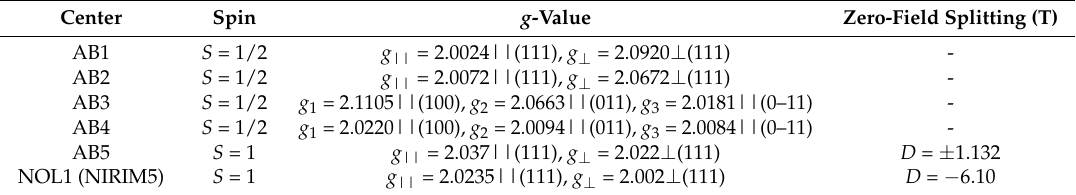
Table 2. Spin-Hamiltonian parameters of the nitrogen-free nickel defects in diamond [26–29]. Center